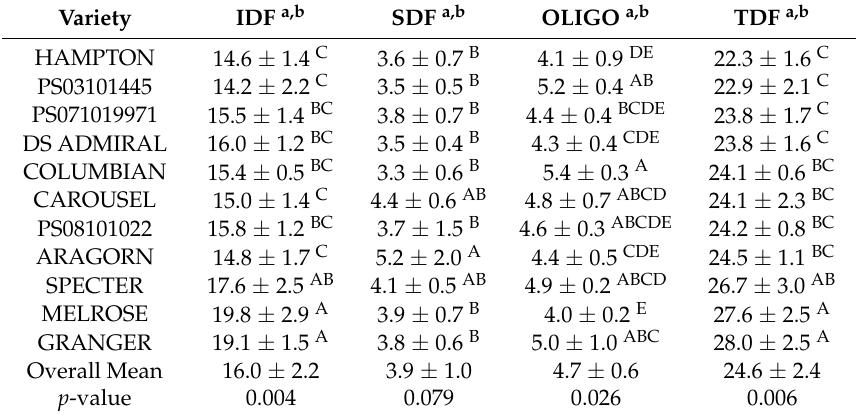
Table 3. Dietary fiber content of dry pea cultivars and breeding